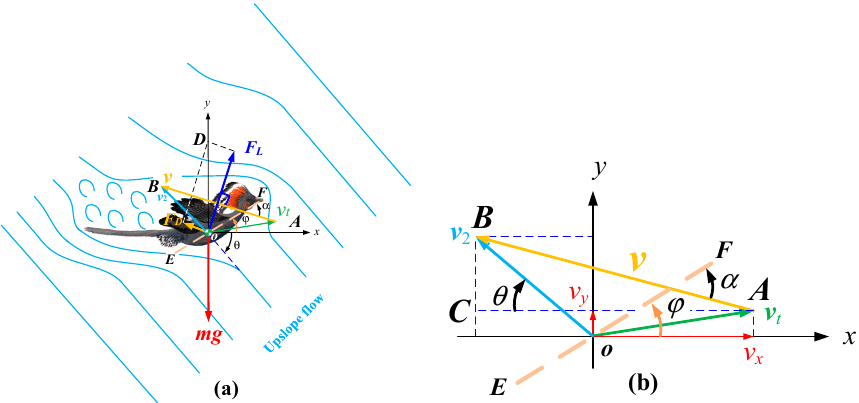
Figure 2. An Anchiornis body with ( a ) a balance of projected lift and drag; ( b ) velocity diagram containing the relative airflow.